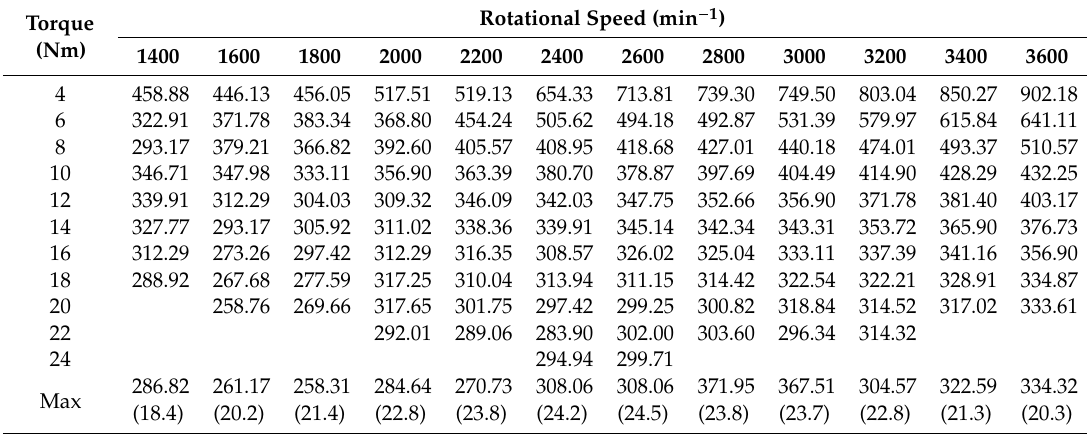
Table A2. Brake specific fuel consumption (g / kWh) of range extender supplied with gasoline. Torque